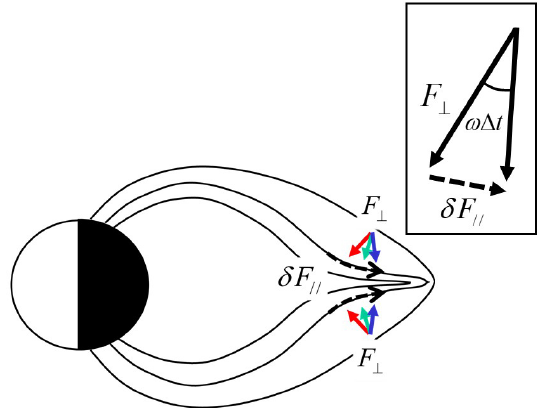
Figure 2. The progression of field line thinning in the growth phase is illustrated. The inflow flux ( F ⊥ ) rotated counterclockwise in times designated by red, green and blue arrows north of the equa- torial plane. South of the equatorial plane, rotation was in a clock- wise direction. The rotation of the inflow vectors produced the field- aligned component of the flux, δF (cid:107) = F ⊥ (ω · δt) as depicted in the inset with one in the Northern Hemisphere shown. Note that inflows are localized earthward of the outer field